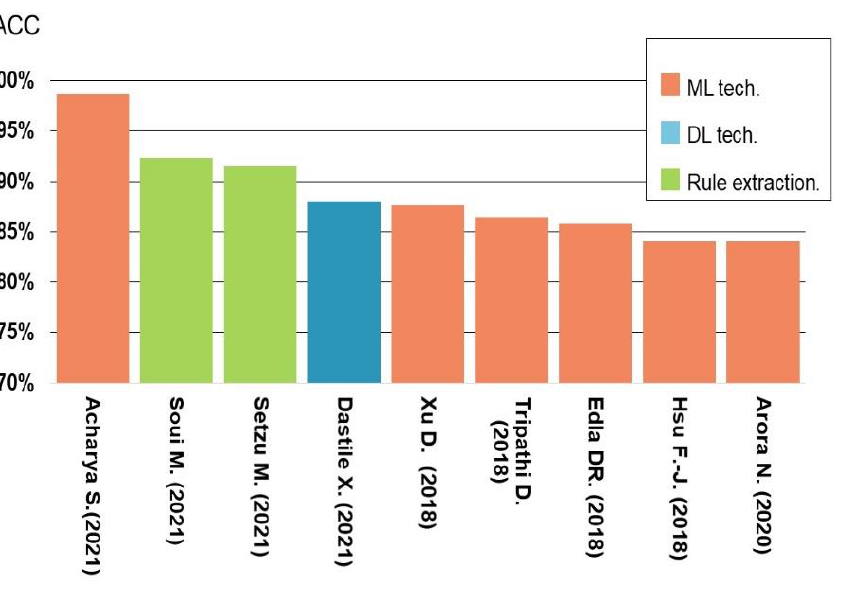
Comparison of accuracy of various methods for the German (categorical) dataset. Table 15. Performance of ensemble and hybrid classifiers, rule-based classifiers, and deep-learning- based classifiers for the German (categorical) dataset.